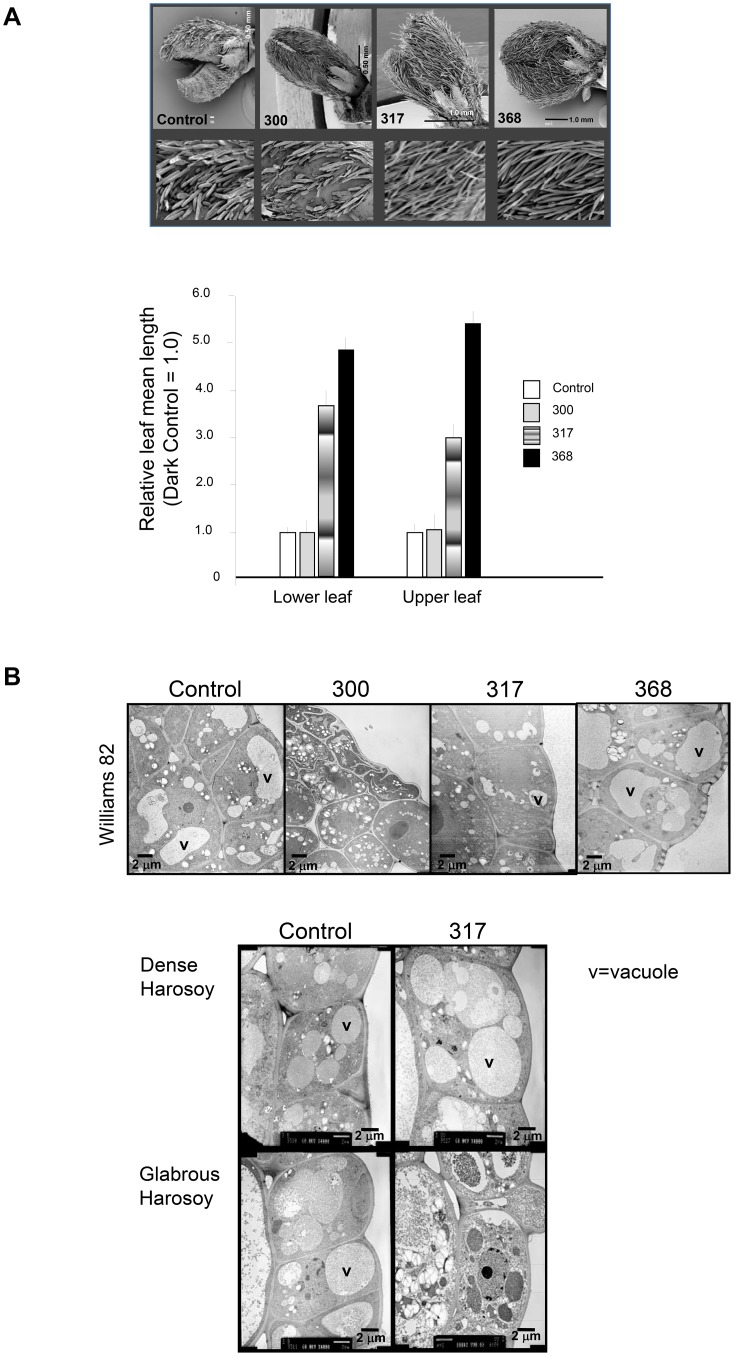
Representative SEM and TEM images of UV-A and UV-B responses. A. SEM indicate developmental response to UV-A and lack of, or inhibited response to 300 nm for development of pubescence.4-d-old seedlings were mock-irradiated (Control) or irradiated with a brief pulse of UV (300, 317 or 368 nm), then returned to the dark for 24 h after which the primary leaves were harvested directly for Scanning Electron Microscopy. Views of the primary leaves of seedlings indicate the side views of the primary leaf pair. The lower panel depicts representative enlarged insets of the side views of the primary leaves showing the rows of hairs. Irradiation treatments are indicated in the Figure. The bar graph depicts the mean length of 10 randomly selected hairs from what will later (after opening) be the abaxial side, with the mean value shown. Mean value of Control seedlings’ primary leaves was set to 1.0, and other treatments thus compared to Control. B. TEM micrographs of etiolated 5-d-old soybean seedlings grown exposed to UV indicate damage at UV-B wavelengths. 4-d-old Williams 82 (the cultivar used throughout unless indicated) seedlings were either mock-irradiated (Control) or irradiated with 104 µmolm−2 of UV (300, 317 or 368 nm), then returned to the dark for 24 h, after which the primary leaves were harvested directly into fixative in the dark to be processed for TEM. Sections were cut perpendicular to the abaxial (top, emergent side of leaf) surface and show the side view of the epidermis and first developing mesophyll cell layer. Representative sections are shown. v = vacuole. Second set (panels below). Soybean cv Harosoy dense (top row) and Harosoy glabrous (bottom row) were sown and grown the same as for Williams 82. The 4-d-old seedlings were either mock-irradiated (Control) or irradiated with 104 µmolm−2 of UV (317 nm), then returned to the dark for 24 h after which the primary leaves were harvested directly into fixative in the dark to be processed for TEM. Sections were cut perpendicular to the abaxial surface, and representative sections are shown. v = vacuole.